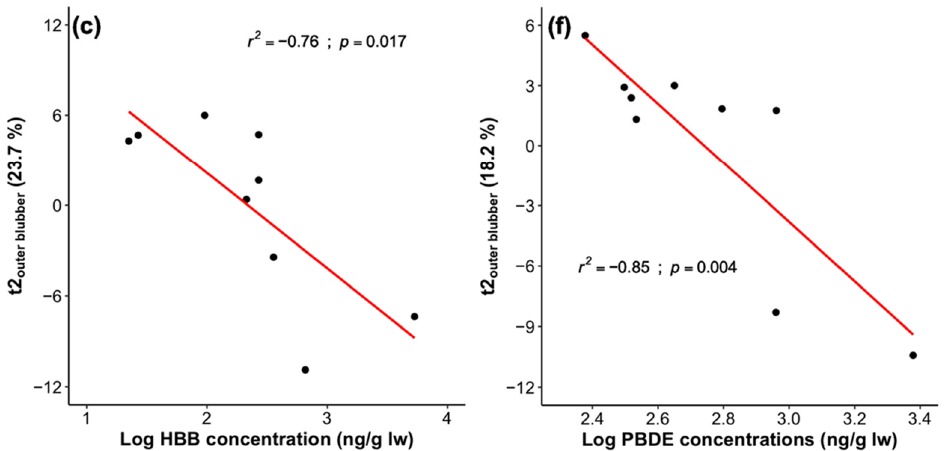
Figure 3. First ( t1 ) and second ( t2 ) principal components were correlated with muscle δ 13 C ( a ) and HBB concentrations ( b , c ) in ringed seals from Lake Melville, and with liver δ 13 C ( d ), total Hg ( e ) and PBDE ( f ) concentrations in Eastern Beaufort Sea belugas. t1 and t2 were obtained from the eight PCAs (one per tissue and per species, i.e., plasma, liver, and inner and outer blubber) performed with log-transformed metabolite percent contribution